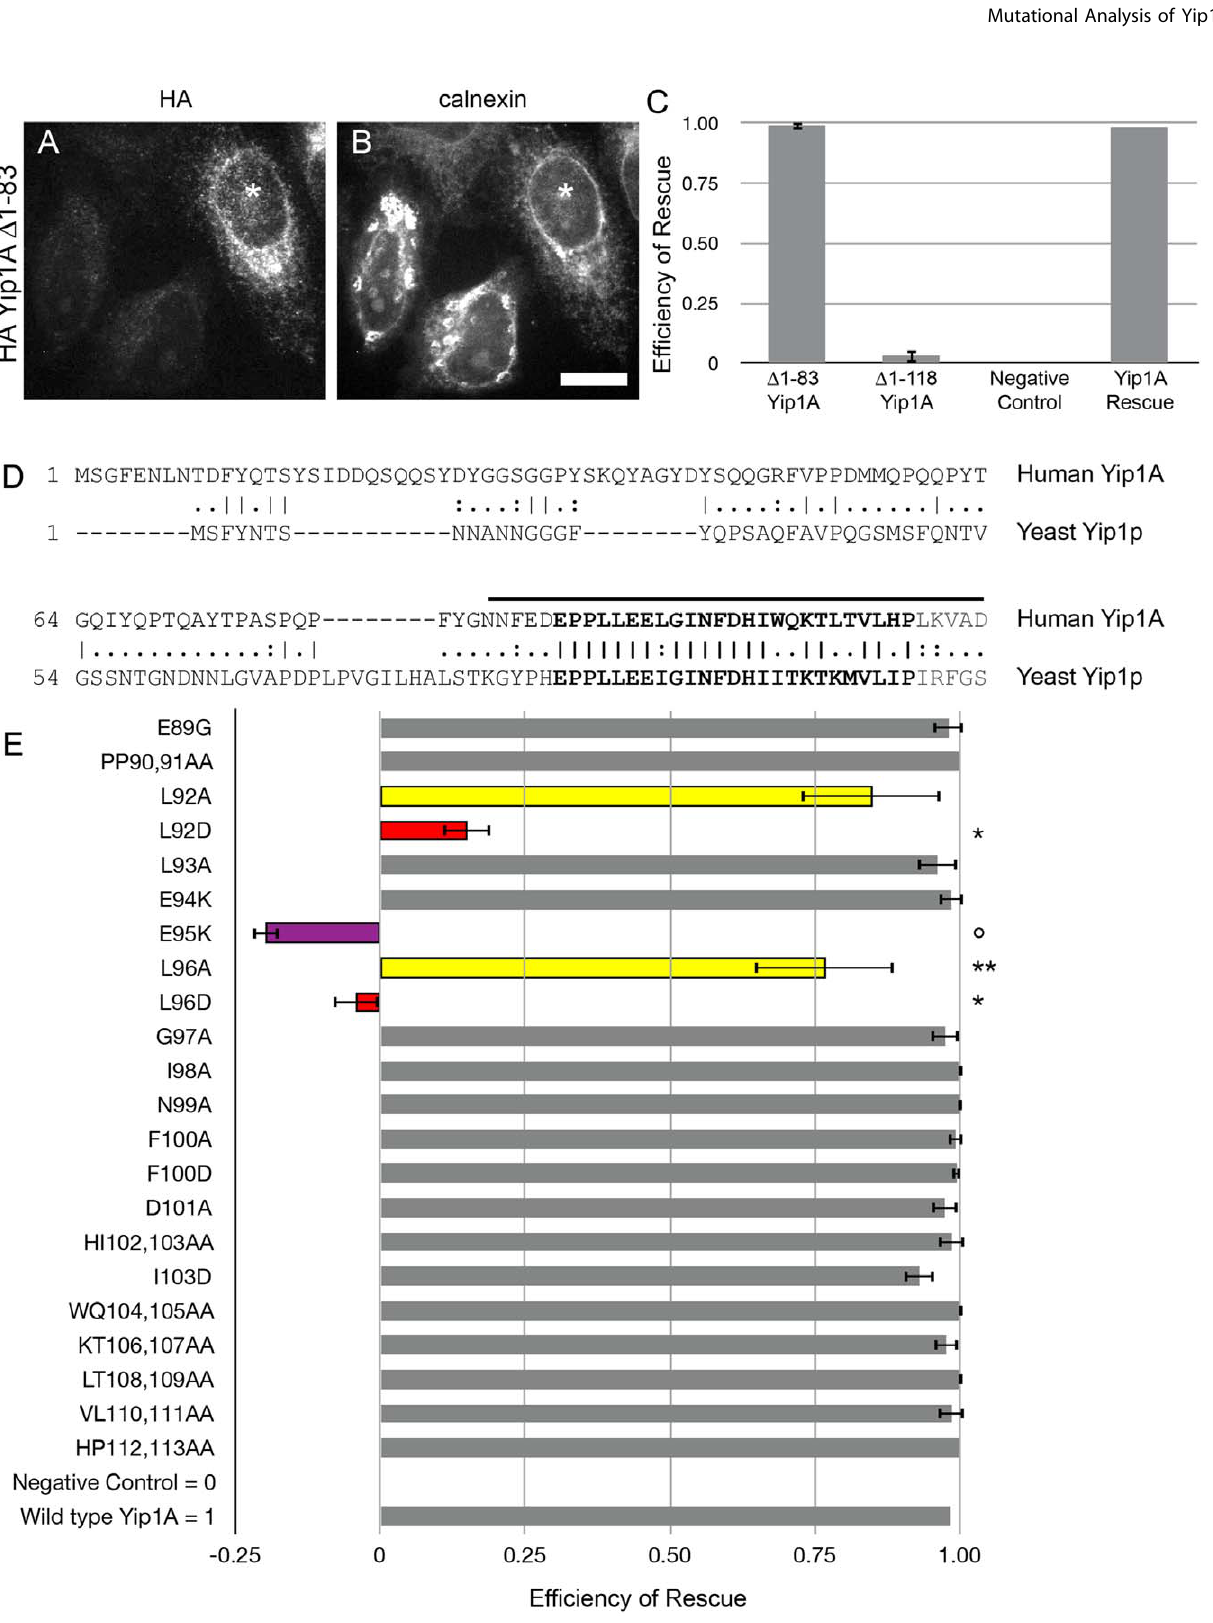
PLOS ONE | www.plosone.org